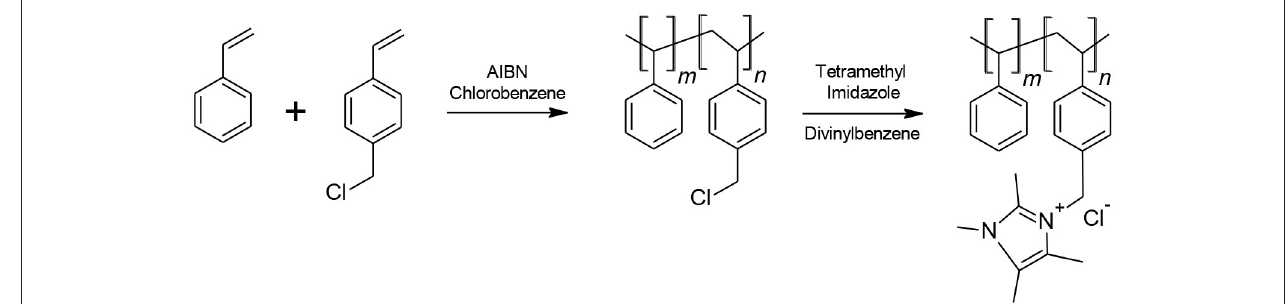
FIGURE 1 | Synthetic route of the pre-polymer in fabricating Sustainion ® anion exchange